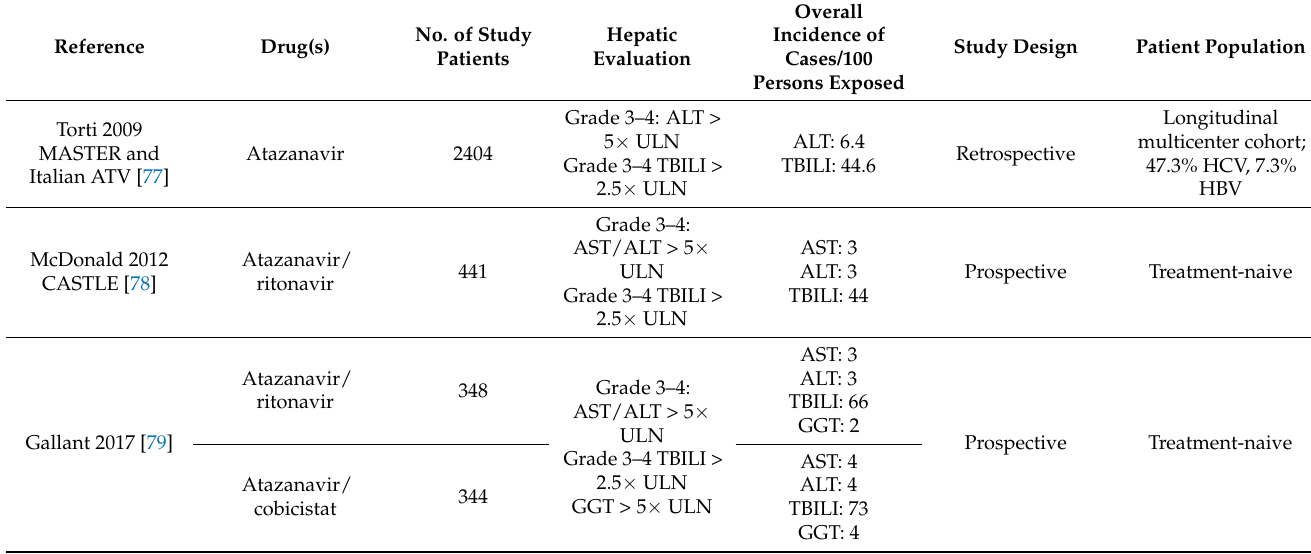
Table 5. Clinical trial evaluation of hepatic toxicity and incidence for protease inhibitors.